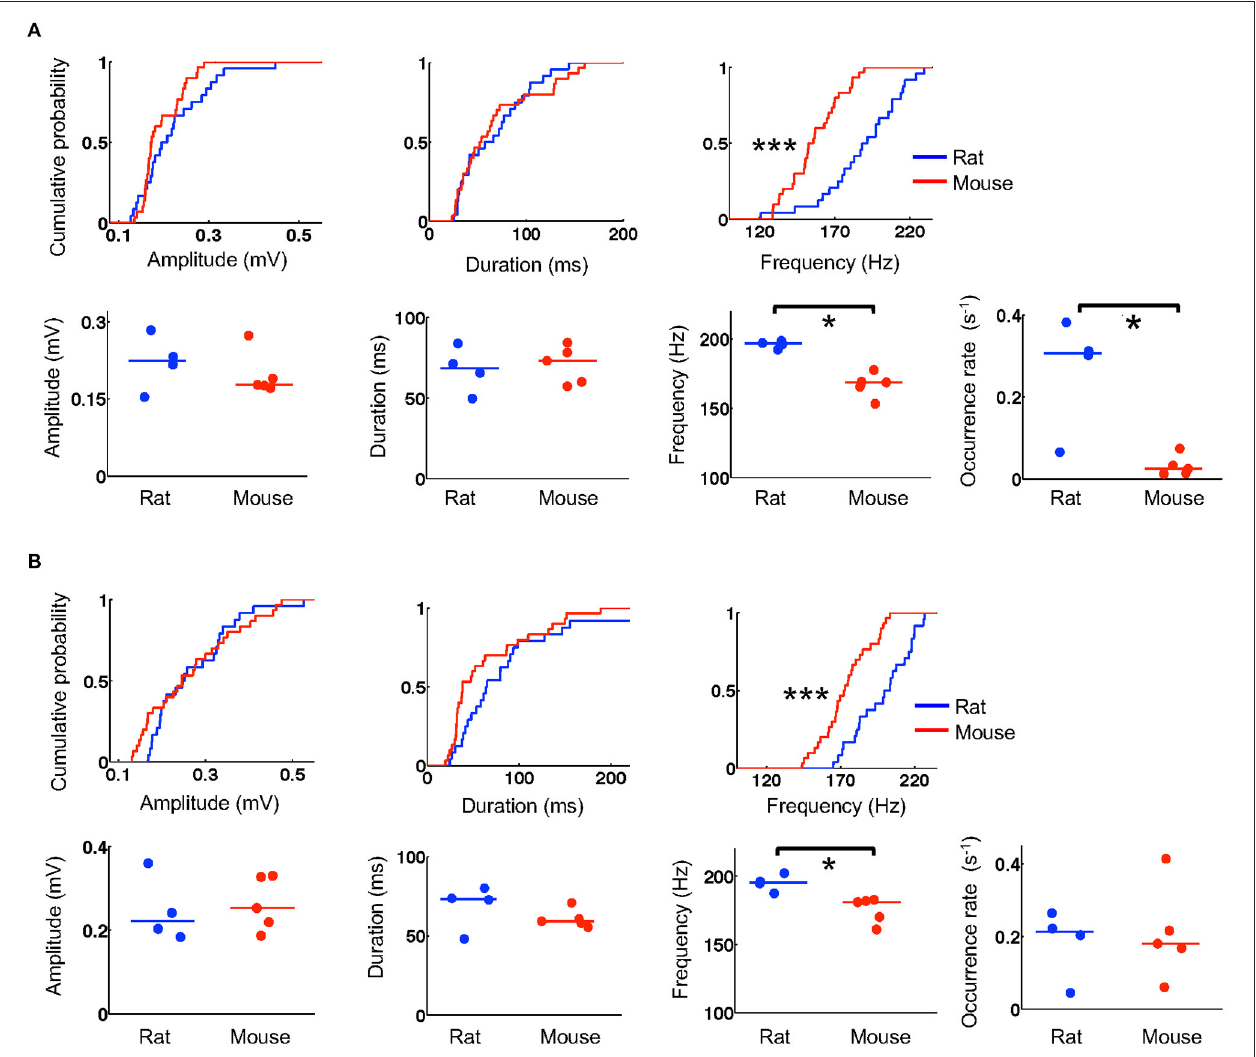
FIGURE 5 | Mouse ripples had lower frequencies. (A) Quantifications of ripple parameters (amplitude, duration, frequency, occurrence rate) during stopping on the novel track. For each column, the top shows the cumulative distribution of a parameter computed from individual ripples sampled equally from all animals in the rat and mouse group ( N = 24 ripples from 4 rats, 30 ripples from 5 mice; 6 ripples per animal). The bottom shows the parameter’s values for individual animals averaged from all ripples detected on the track. Lines: median values. * P < 0.05, *** P < 0.001. (B) Same as in (A) , but for ripples during resting in a box after the track running.